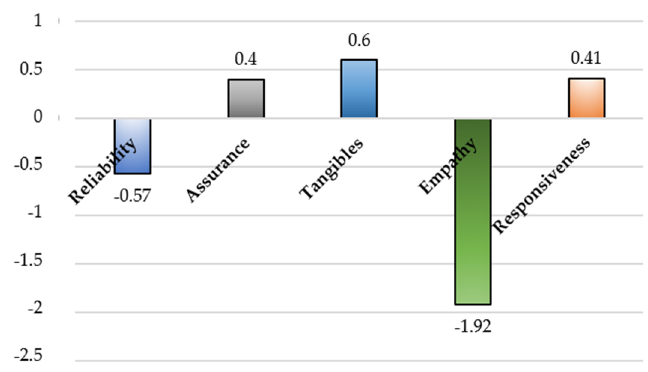
Figure 12. Arithmetic mean score for Servqual analysis dimensions. Source: own study.